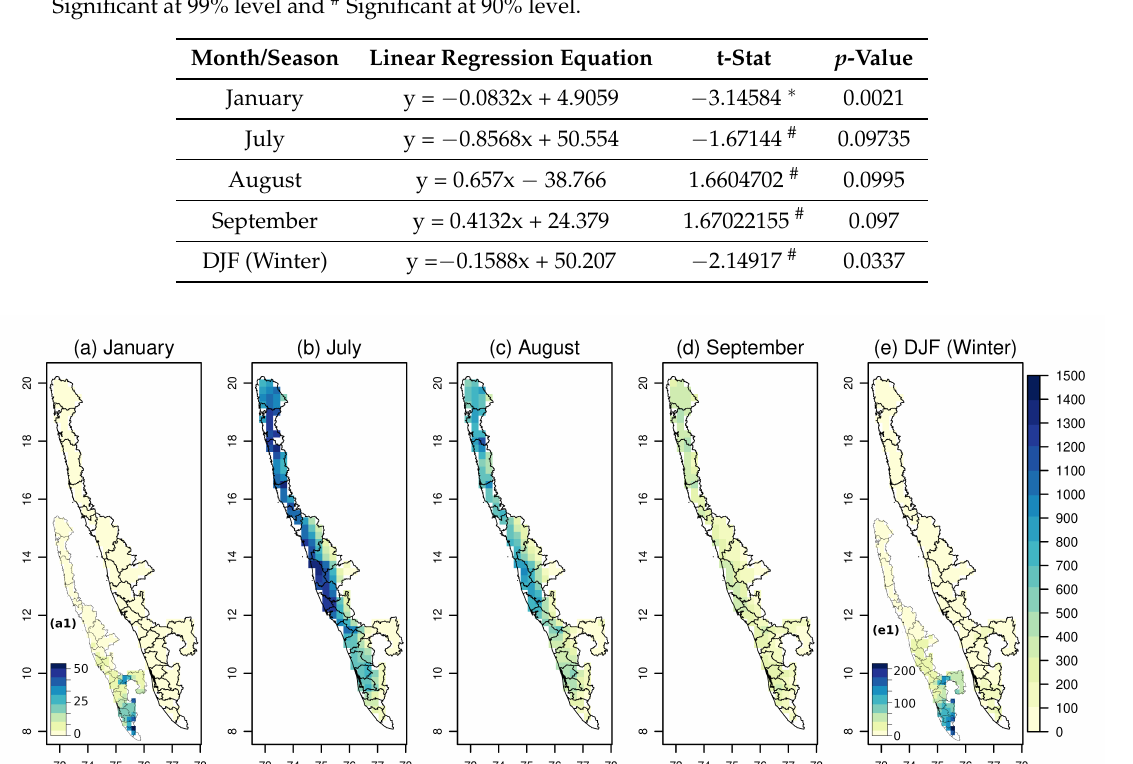
Figure 3. ( a – e ) Distribution of mean total rainfall for the period 1901–2017 in different months and seasons. Among all the figures ( a – e ), uniformity in the use of the color bar is maintained for the representation of the magnitude of the rainfall amount. Whereas, to show the spatial variation within the region, Figure 3a and Figure 3e have inset ( a1 ) and ( e1 ) respectively. The unit of rainfall is